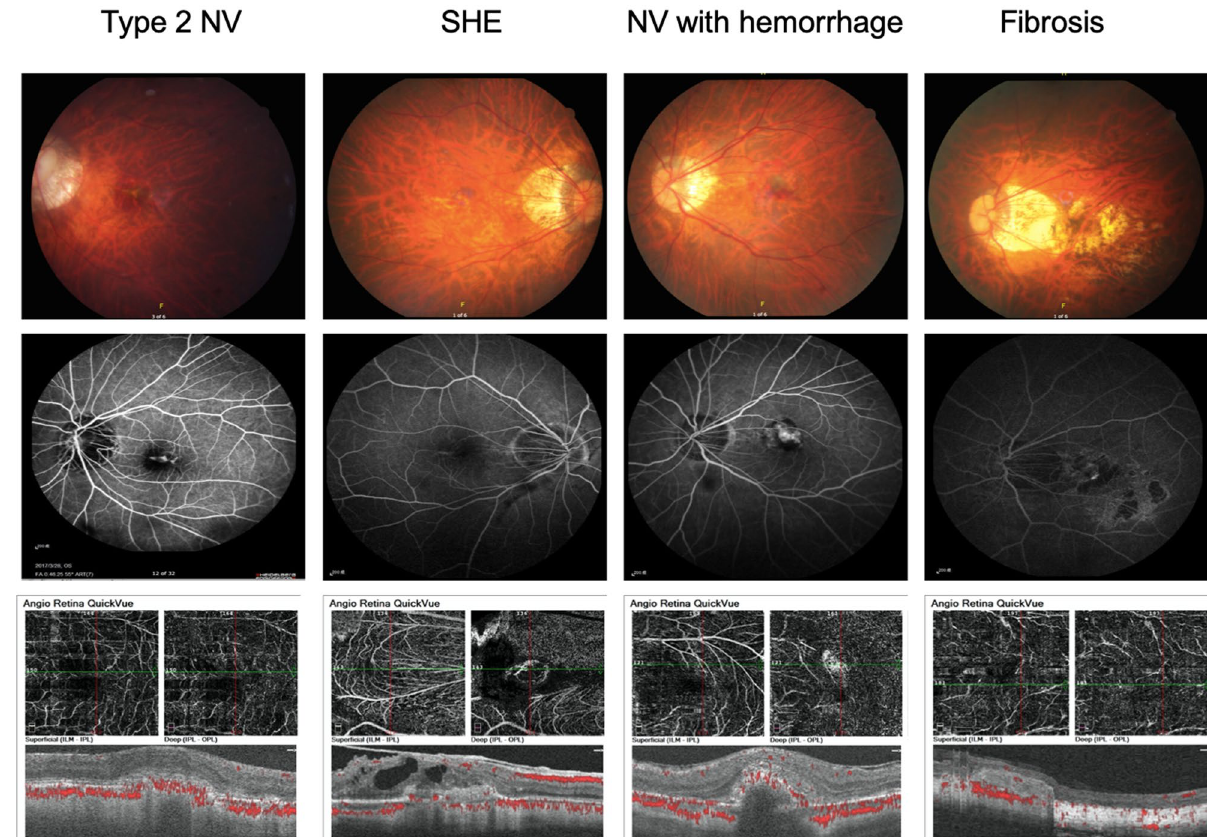
Figure 1. Color fundus photographs and fluorescein angiography and OCT angiography images of different SHRM. SHRM subretinal hyperreflective material, SHE subretinal hyperreflective exudation, NV neovascularization, OCT optical coherence tomography.